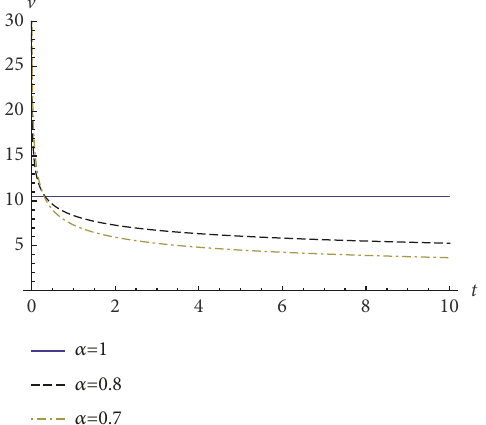
Figure 4: Fractional one-solitons determined by solution (43) at time 𝑡 = 195